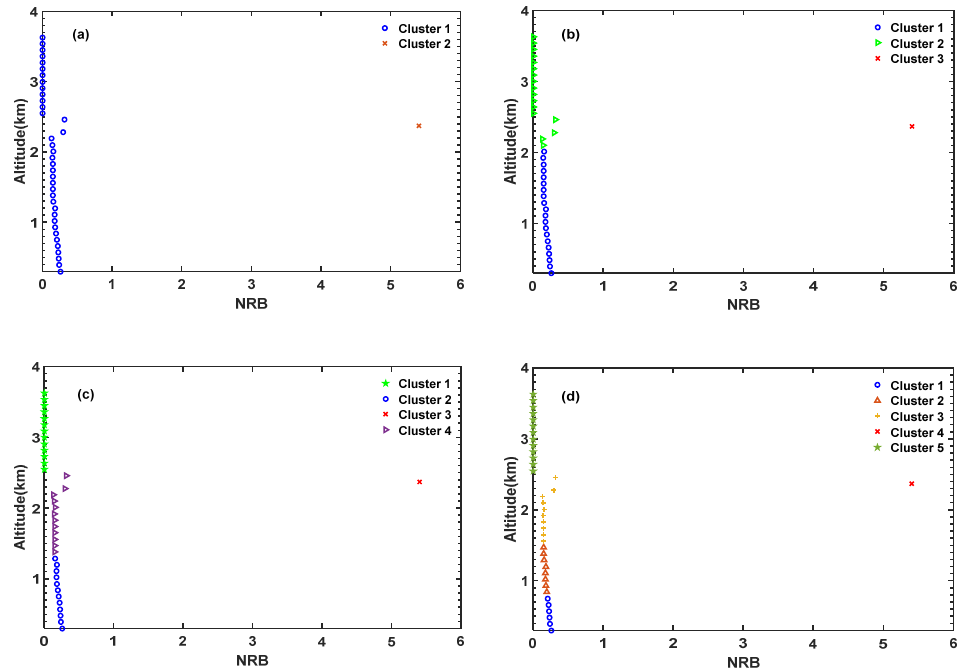
Figure 2. The clustering under a different number of clusters with random initial center: ( a ) k = 2; ( b ) k = 3; ( c ) k = 4; ( d ) k = 5.